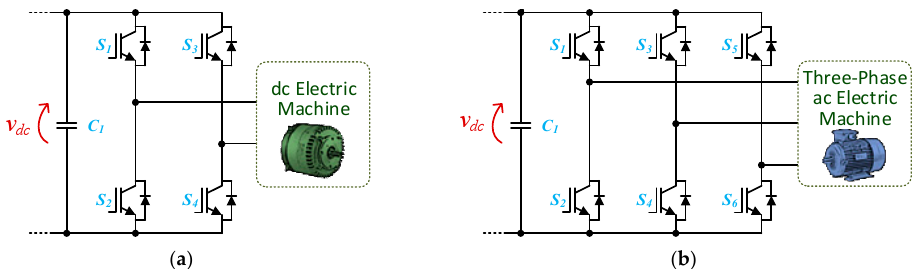
Figure 18 . Voltage source power converter for the control of: ( a ) dc electric machines; ( b ) three-phase ac electric machines.